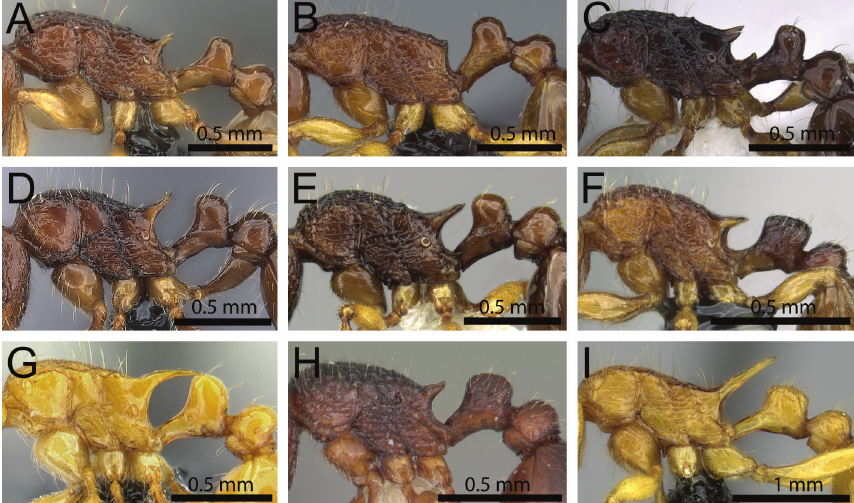
Figure 21. Mesosoma and waist segments in profile. A T. pseudogladius (CASENT0153605) B T. merina (CASENT0437226) C T. scutum (CASENT0189116) D T. alperti (CASENT0042547) E T. vohitra (CASENT0189167) F T. fhg-forc (CASENT0150949) G T. shamshir (CASENT0467696) H T. qua-